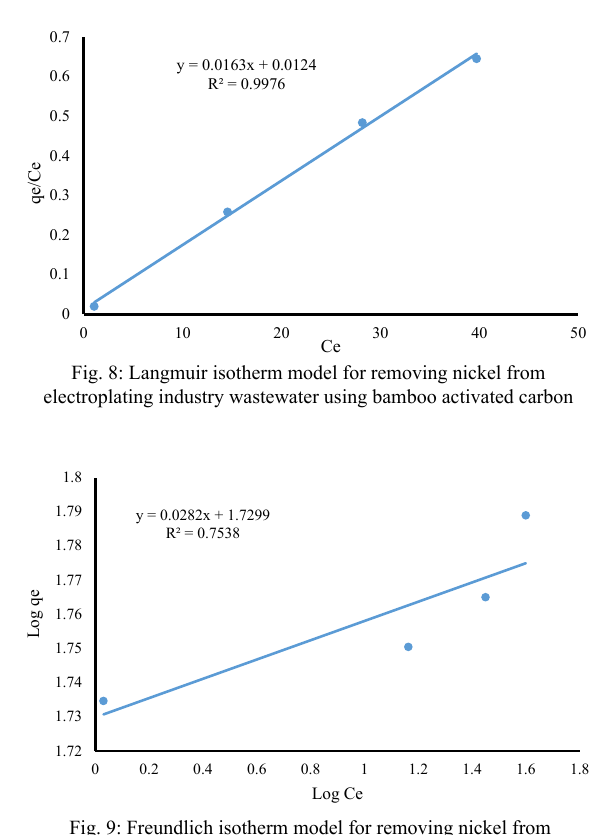
Fig. 9: Freundlich isotherm model for removing nickel from electroplating industry wastewater using bamboo activated carbon